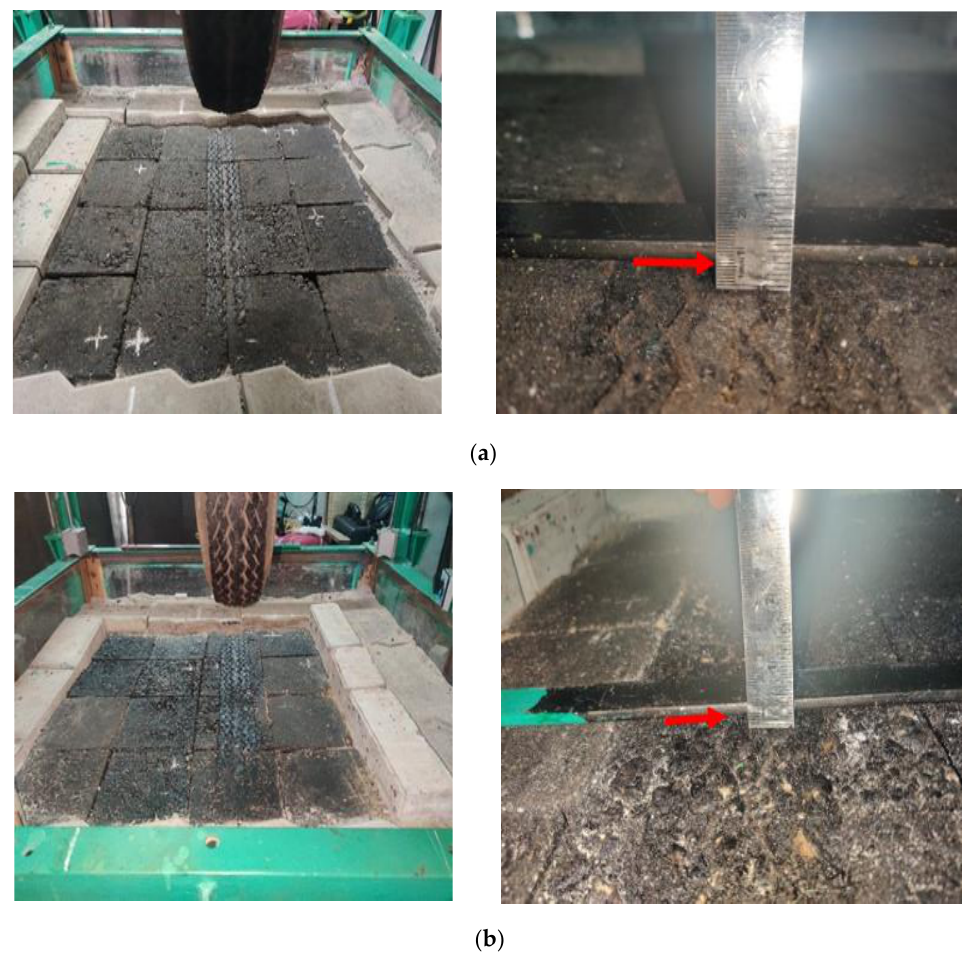
Figure 7. Bituminous block pavement setup ( a ) subgrade (300 mm thick); ( b ) sub-base (150 mm thick); ( c ) base course (250 mm thick); ( d ) bituminous block (55 mm thick); ( e ) loading over the cen- ter; ( f ) loading over the middle.